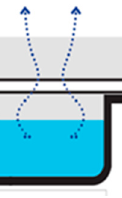
Figure 2. Diagram of wet cup test method [13].